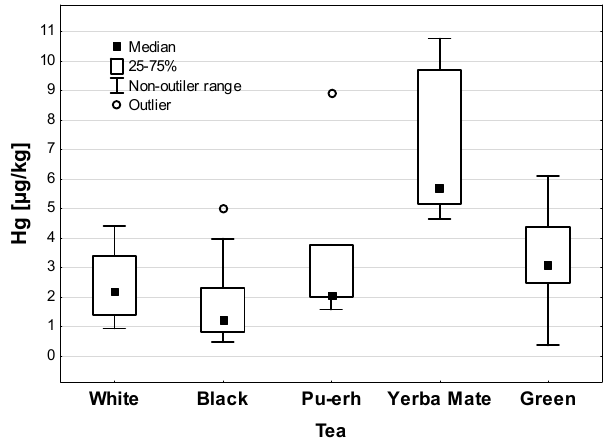
Figure 1. Hg concentration in different kinds of tea ( μ g/kg).